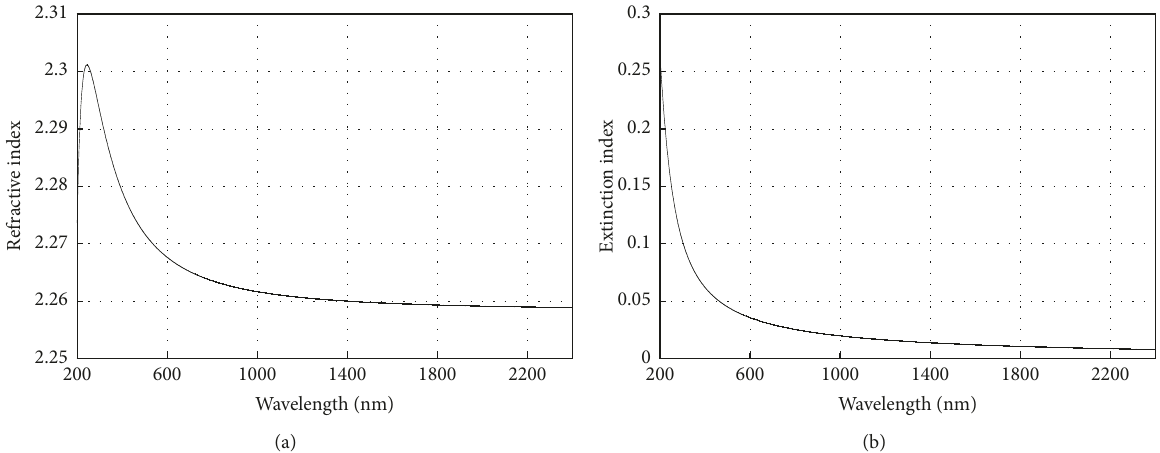
Figure 8: Comparison of the real (a) and imaginary (b) parts of the complex refractive index for the UV-exposed thin film (see Figure 6).